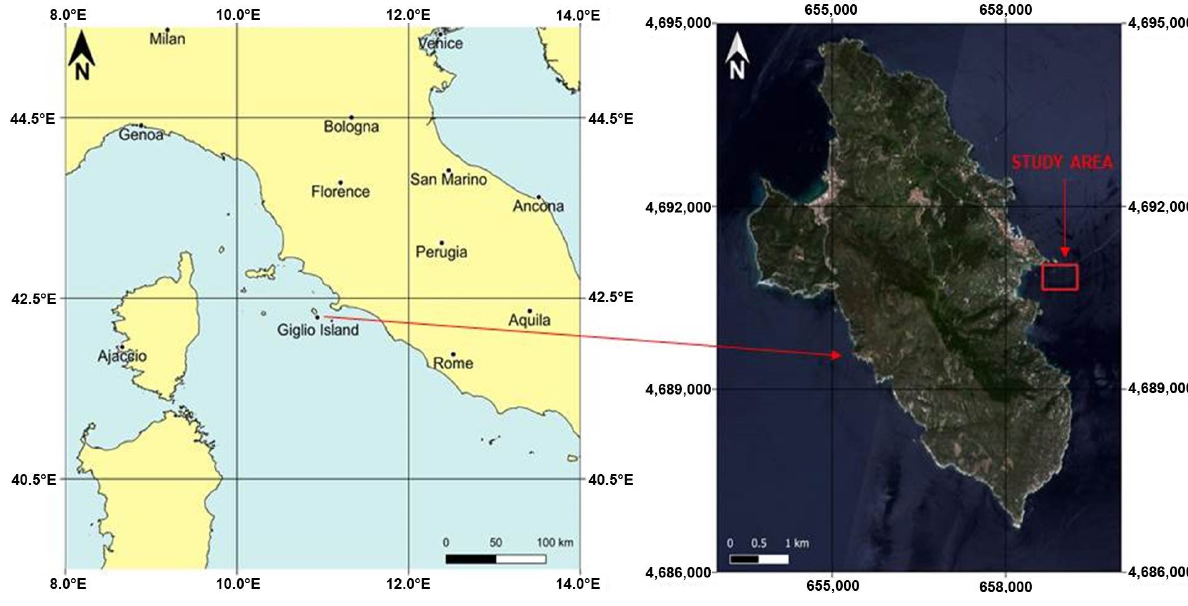
Figure 2. The study area: on the left, localization of Giglio Island into Tyrrhenian Sea, in equirectangular projection and WGS84 geographic coordinates (EPSG: 4326); on the right, Giglio Island visualization in RGB composition of Sentinel-2B images in UTM/WGS 84 plane coordinates expressed in meters (EPSG: 32632), with the study area highlighted in the red rectangle.